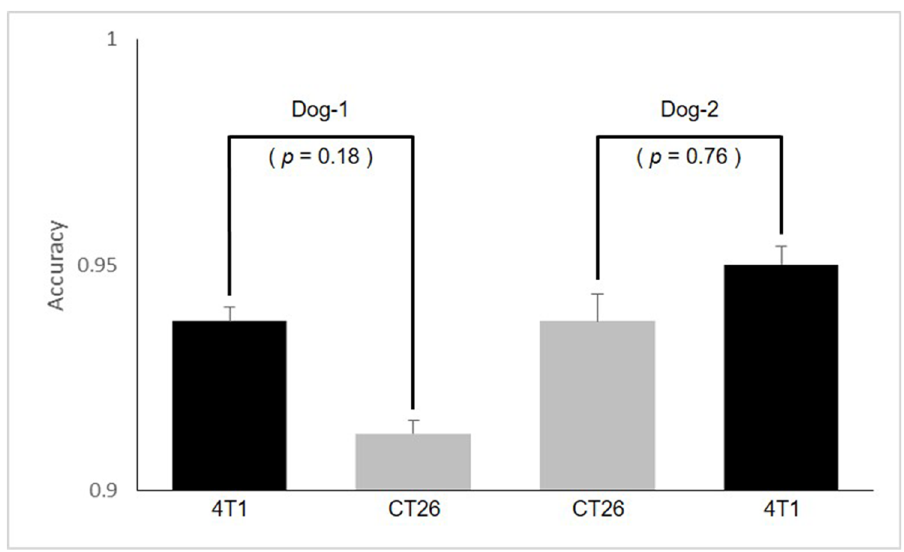
Fig 2. The statistical differences between two cancer samples for each